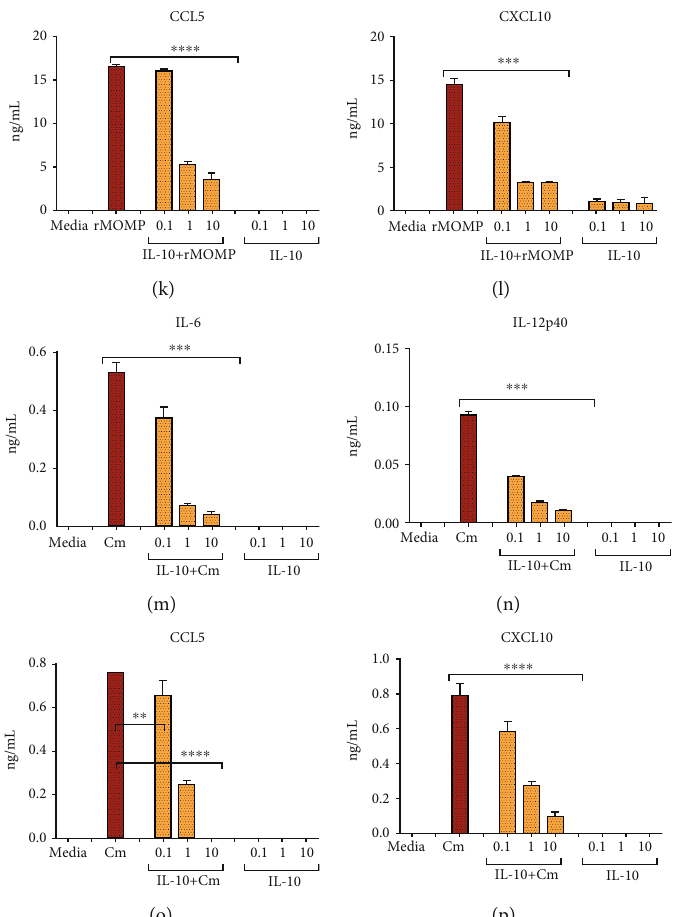
Figure 1: MOMP is a potent inducer of in fl ammatory mediators that are dose-dependently inhibited by added IL-10 to macrophages. For chlamydial stimulant dose-dependent studies, macrophages (10 6 cells/mL) were stimulated with rMOMP at 0.1, 1 and 10 μ g/mL (A-D) or live Cm at MOIs of 0.5, 1 and 2 (E-H) in the presence and absence of IL-10 (10 ng/mL). For IL-10 dose-dependent studies, macrophages were stimulated with rMOMP at 10 μ g/mL (I-L) or Cm at an MOI of 2 (M-P) in the presence and absence of varying dosages of IL-10 (0.1, 1 and 10ng/mL). Cell-free culture supernatants were collected after 24h to quantify cytokines and chemokines by speci fi c ELISAs. Asterisks indicate signi fi cant di ff erences between stimulated macrophages alone and those with added IL-10 ( P < 0.05). P values were calculated by the use of ANOVA followed by Turkey ’ s Post-test using GraphPad Prism 6 Software. Each bar represents the mean ± SD of samples run in triplicates. Each experiment was repeated at least 4 times with similar results and shown is a representative